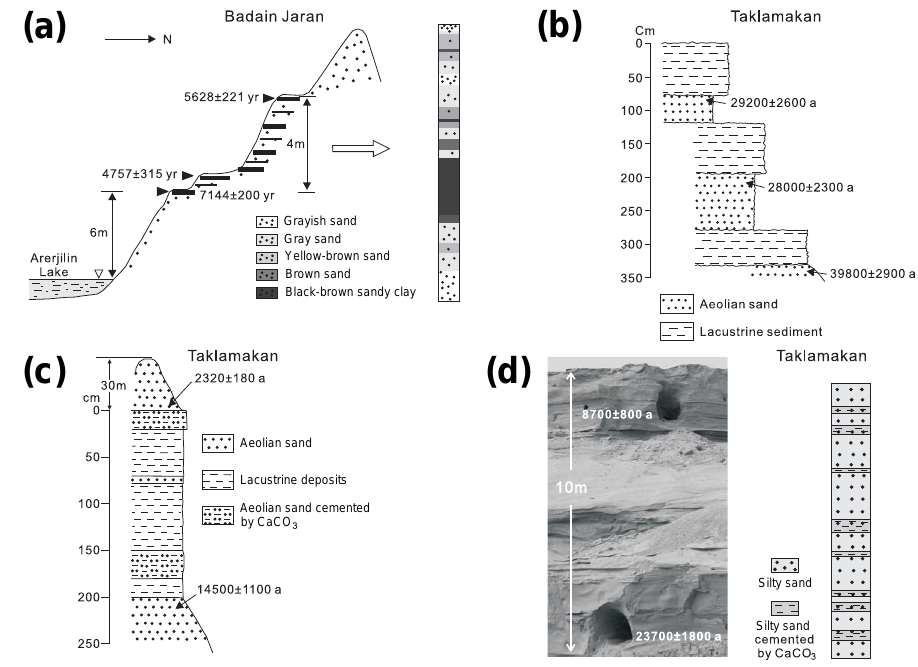
Figure 3. Sketch maps of the sedimentary profiles studied in this study. (a) Lacustrine sediments interbedded by aeolian sand layers with 14 C ages at the Arerjilin-I section in the Badain Jaran Desert, (b) interbedding of aeolian and lacustrine deposits and their OSL ages at the Tazhong-XIII section in the Taklamakan Desert, (c) lacustrine deposits buried under a 30m high dune at the Yaogan-VIII section in southern Taklamakan, and (d) sandy loess deposits with OSL dating results at the Tumiya-II section on the southern margin of the Taklamakan